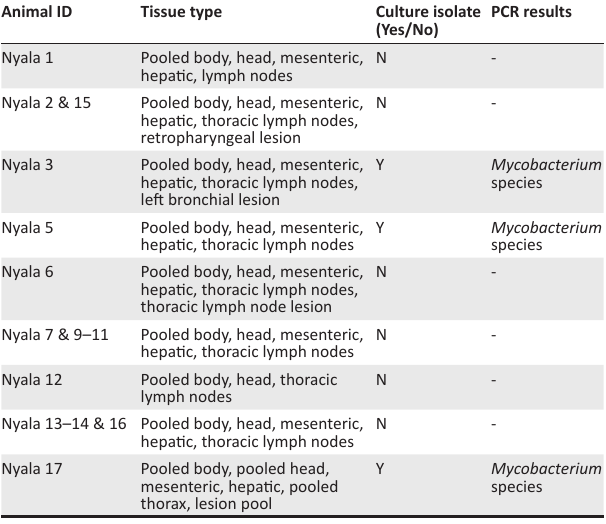
TABLE 1: Results of bacterial culture (and polymerase chain reaction) of tissue samples from nyala. Animal ID Tissue type Culture isolate